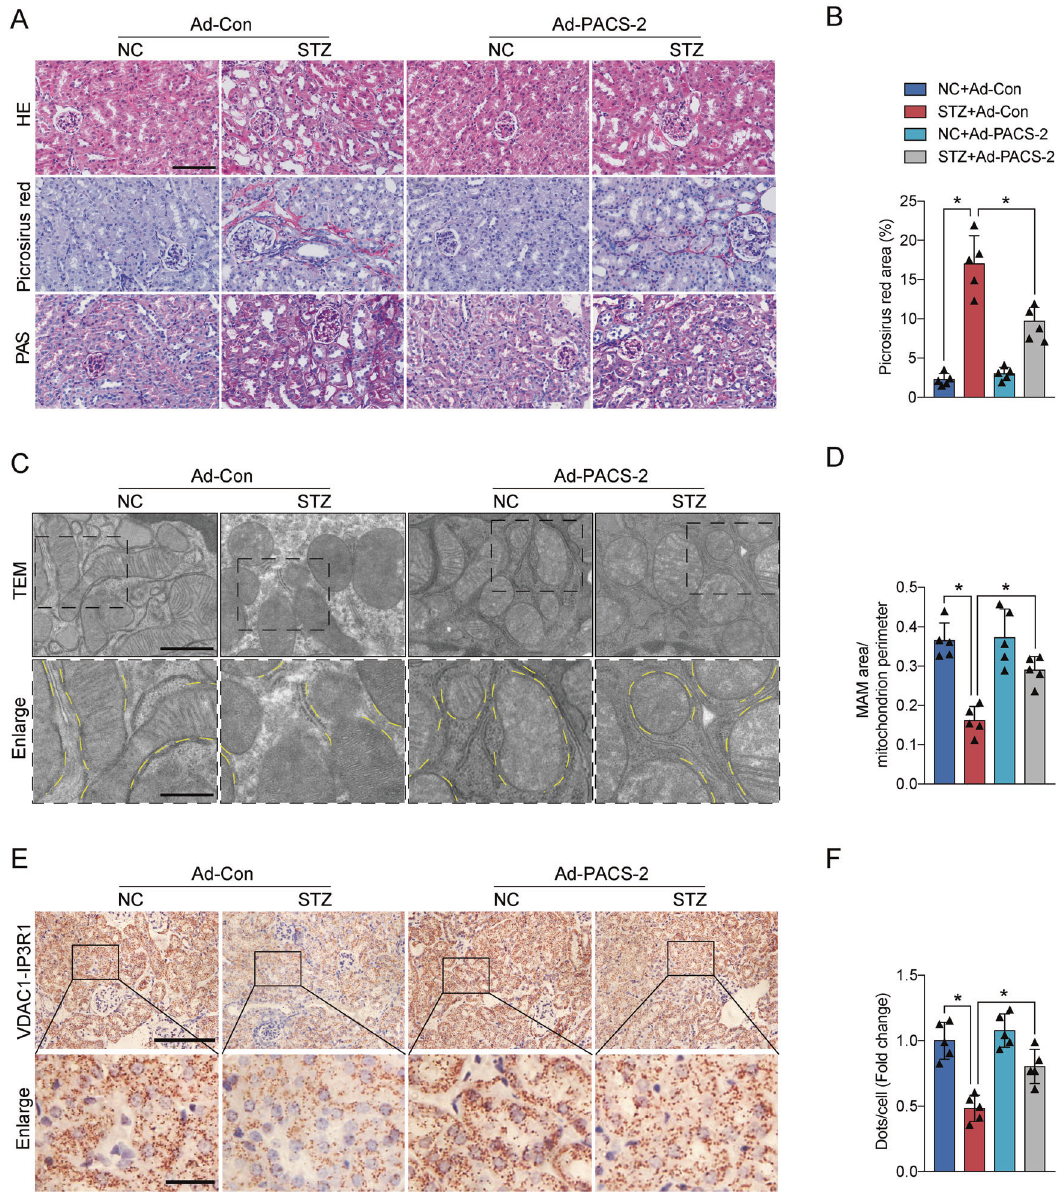
Fig. 4 Renal histopathological changes were improved and MAM formation was enhanced after PACS-2 overexpression. A Representative images of HE, Picrosirius red, and PAS staining of kidney sections. Scale bar = 100 μ m. B Quantitative analysis of Picrosirius red staining in A . n = 5. C Representative TEM images showing the MAM area in the kidneys. Yellow lines indicate the MAM interface. Scale bars = 1 μ m, inset scale bar = 500 nm. D Quantitative analysis of MAM area normalized to mitochondrion perimeter in C . n = 5. E Representative in situ PLA images showing the VDAC1/IP3R1 interactions in the kidneys. Scale bars = 100 μ m, inset scale bar = 20 μ m. F Quantitative analysis of in situ PLA dots in E . n = 5. All data are expressed as mean ± SD. * P < 0.05. increased in the diabetic group compared with the control group, (ALT), aspartate aminotransferase (AST), triglyceride (TG), and total whereas they were further increased in the diabetic Pacs-2 − / − cholesterol (TC) between the diabetic and diabetic Pacs-2 − / − mice (Supplementary Table 3). The diabetes-associated tubular changes group (Fig. 3A, B). Diabetic mice also exhibited an impairment in and tubulointerstitial fi brosis were more severe and the ER- mitochondrial function accompanied by decreased levels of TFAM, mitochondria interaction sites were less in the diabetic Pacs-2 − / − PGC1 α , and mitochondrial DNA (mtDNA) copy number, while the mitochondrial function was worsened in diabetic mice with PACS- group than in the diabetic group (Fig. 2A – D). In addition, in situ 2 deletion (Fig. 3C – E). Furthermore, in comparison with non- PLA was performed to analyze the mutual combination of VDAC1 diabetic mice, diabetic mice showed marked renal apoptosis and and IP3R1 for visualizing the mitochondrial and ER contact. fi brosis as indicated by a substantially elevated proportion of Consistently, compared with the diabetic group, the least VDAC1/ apoptotic cells and upregulated expression of Bax/Bcl2, cleaved IP3R1 complexes were found in the diabetic Pacs-2 − / − group Caspase3, Fibronectin, and Col4 α 1. Interestingly, renal apoptosis (Fig. 2E, F). and fi brosis levels were further enhanced in diabetic Pacs-2 − / − The expression levels of the ER stress protein including Grp78, p-PERK/PERK, p-eIF2 α /eIF2 α , ATF4, and CHOP were notably mice (Fig. 3F – J and Supplementary Fig. 4A). Cell Death and Disease (2021)